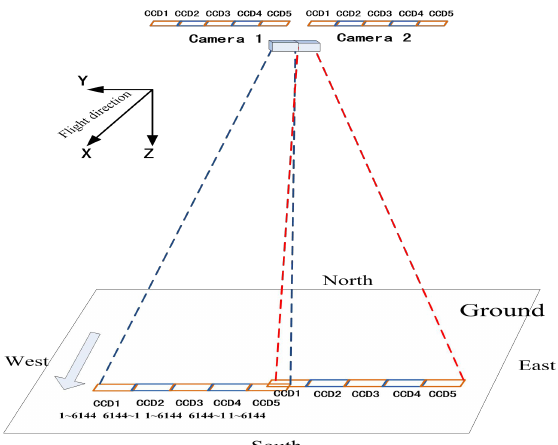
Figure 1. the geometric characteristics of GF-2 dual- camera High-resolution satellites rarely use multiple cameras to achieve a wide swath and relevant technical documents and literature are found few. Several researchers focused on image stitching with weak geometry. Jcobsen et al. proposed a simple image shift method to stitch for the three CCD line-sensors of the IRS- 1C satellite panchromatic camera, and the accuracy of the model is from 0.2 to 0.6 pixels in image space [2]. Zhang and Tang et al. used an inner field of view (FOV) stitching method based on virtual CCD line, ZY-3 and ALOS/PRISM images are used to verify the algorithm [3-4]. However, the potential error sources of the method are analysed deeply. The stitching error caused by elevation error cannot be ignored, especially for the elevation more than 300 meters,it will cause 1 pixel stitching error in push-broom direction